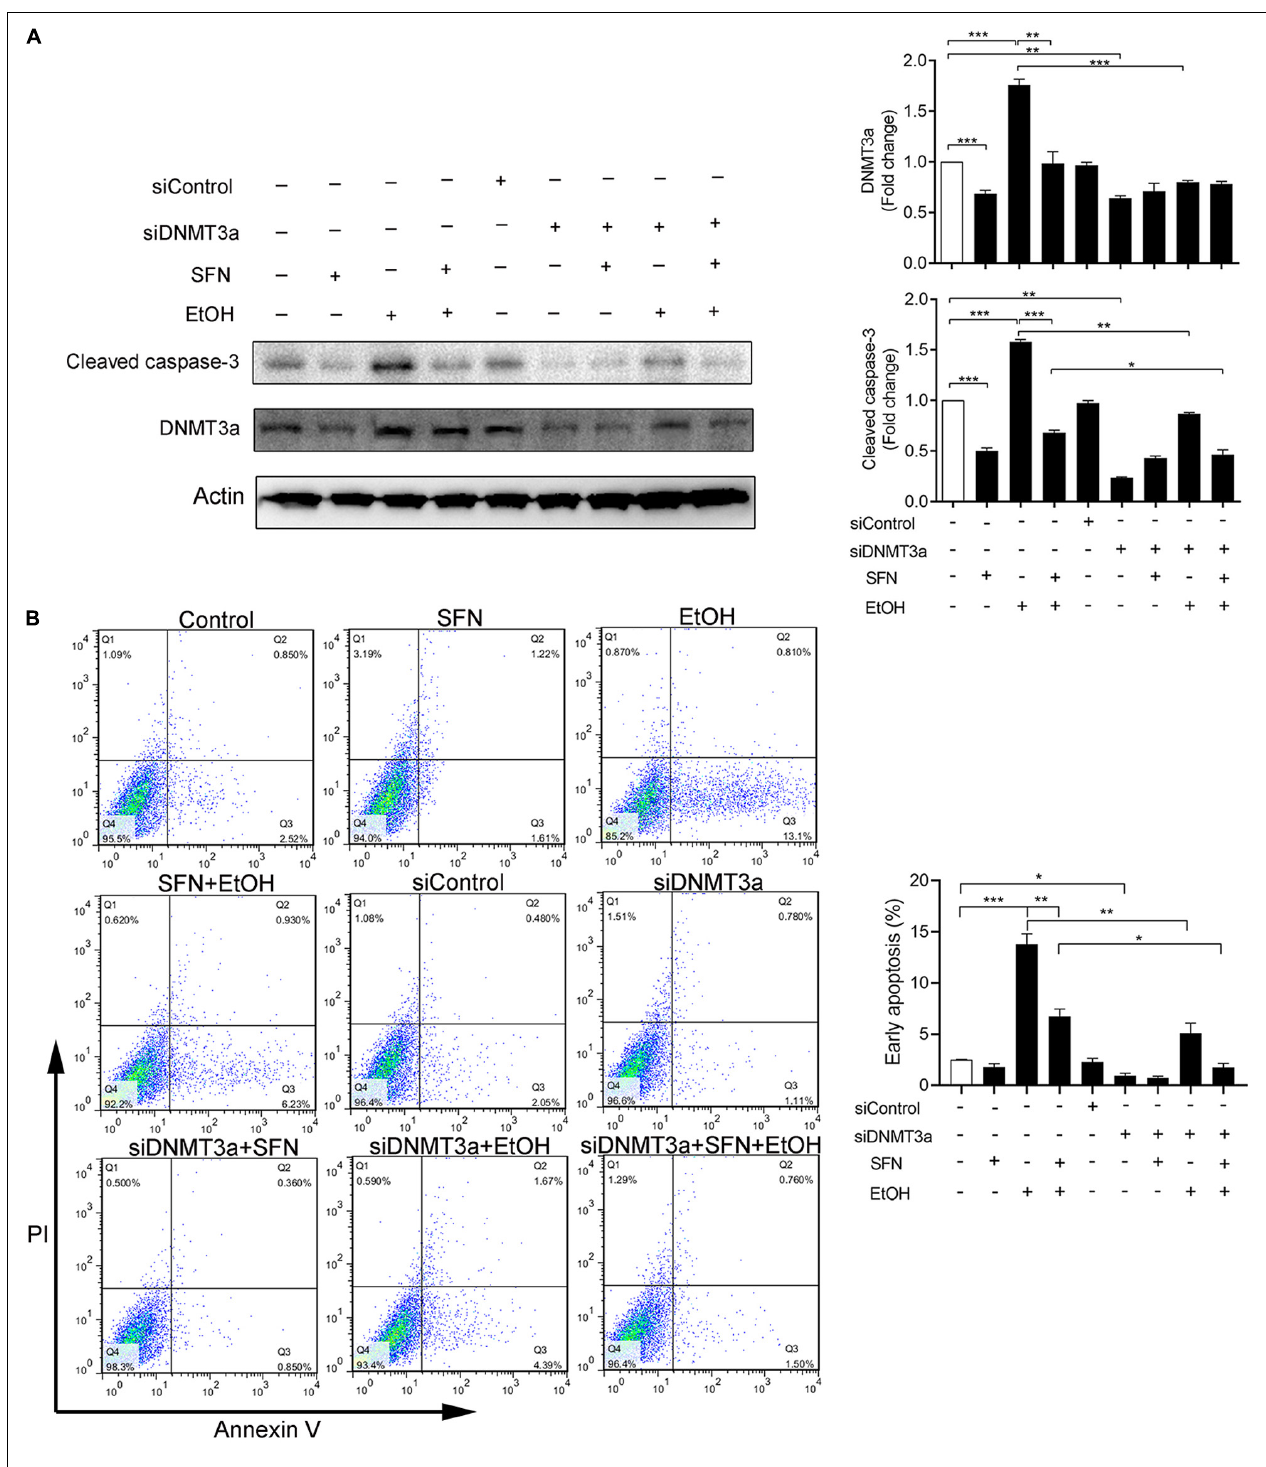
FIGURE 6 | The knockdown of DNMT3a diminished ethanol-induced apoptosis and enhanced the protective effects of SFN in hNCCs. hNCCs transfected with control-siRNA or DNMT3a-siRNA were treated with 1 µ M SFN for 24 h, followed by concurrent exposure to 1 µ M SFN and 50 mM ethanol for an additional 24 h. The protein expression of DNMT3a was determined by Western blotting (A) . Apoptosis was determined by the analysis of caspase-3 cleavage by Western blotting (A) or flow cytometry with Annexin V-FITC apoptosis detection kit (B) . Data are expressed as fold change over control (A) or percentage (B) and represent the mean ± SEM of three separated experiments. * p < 0.05, ** p < 0.01, *** p < 0.001.